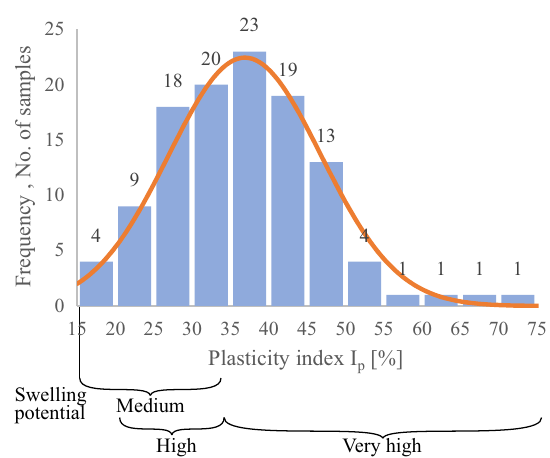
Fig. 10 Histogram of the samples Plasticity index (Ip) and swelling potential according to (Peck et al. 1974; Bowles 1996)